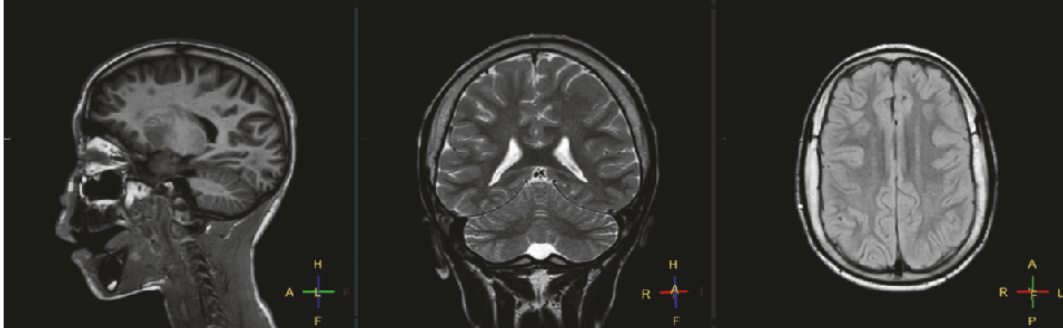
Figure 2: Brain MRI (sagittal, coronal, and axial views) showed a diffuse hyperintensity of supratentorial white matter, a moderate enlarge- ment of the lateral ventricles, a moderate expansion of hemispheric grooves, and a thickening of the cranial vault.